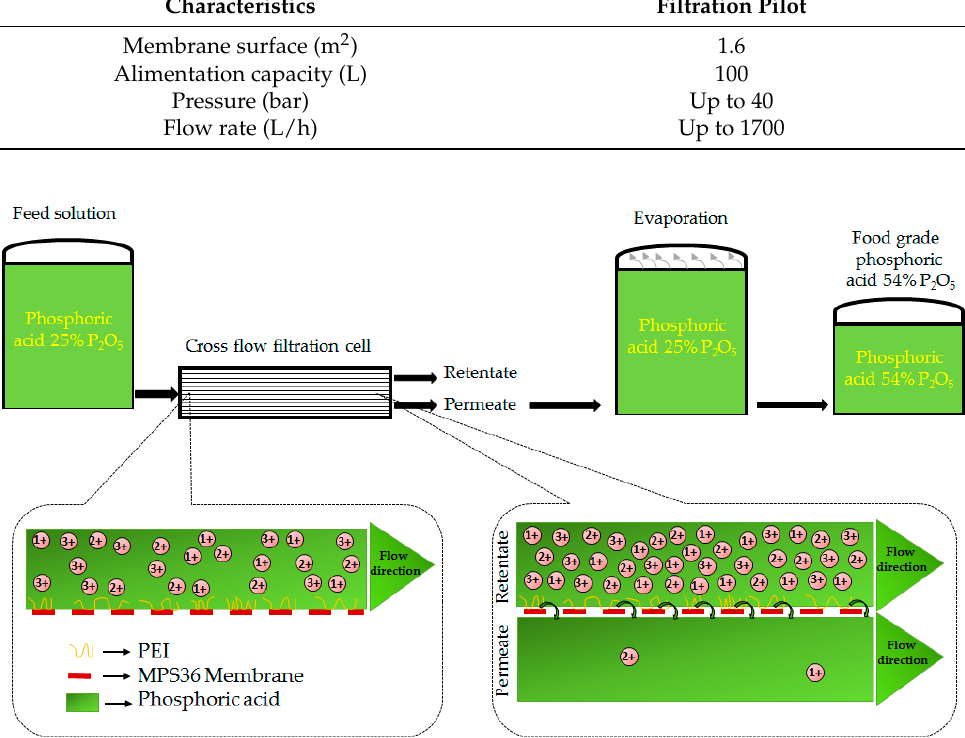
Figure 1. Schematic representation of the purification process.